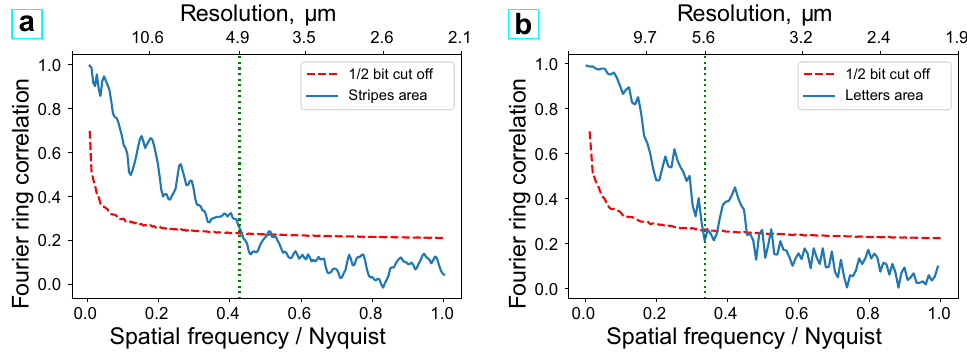
Figure 5. ( a , b ) Estimated resolutions of reconstructions using Fourier ring correlation, ( a , b ) correspond to Fig. 4 ( c , d ),